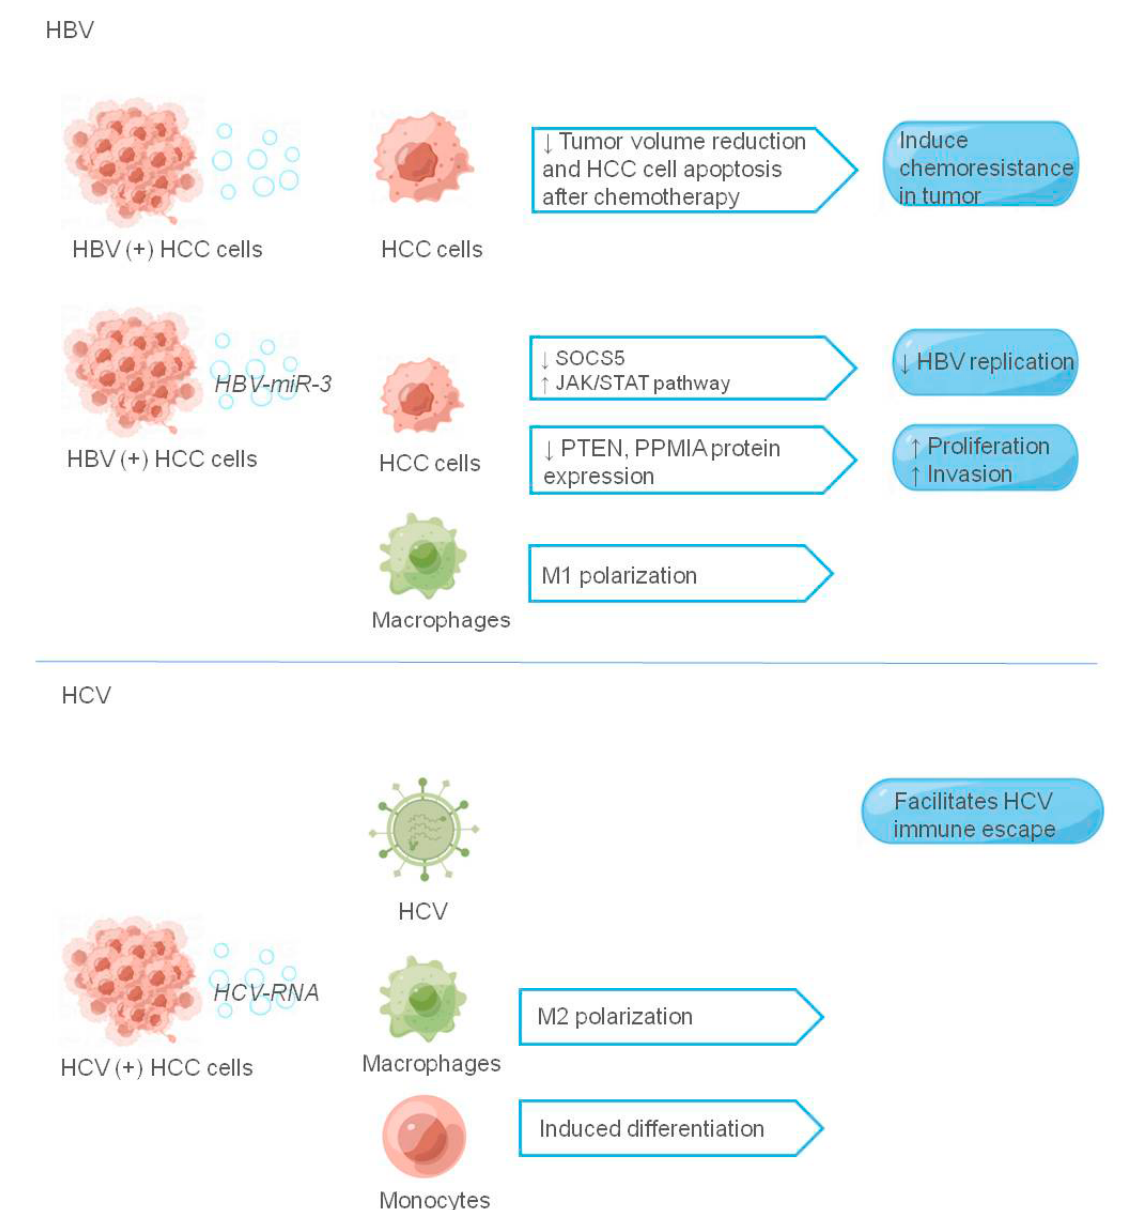
Figure 4. The role of exosomes in hepatitis virus-associated tumor microenvironment. The figure shows the liver cancer-related virus components and their receptors that play a role in exosomes, and the liver cancer-related virus components are shown in italics, ↑ indicating promotion and ↓ indicating